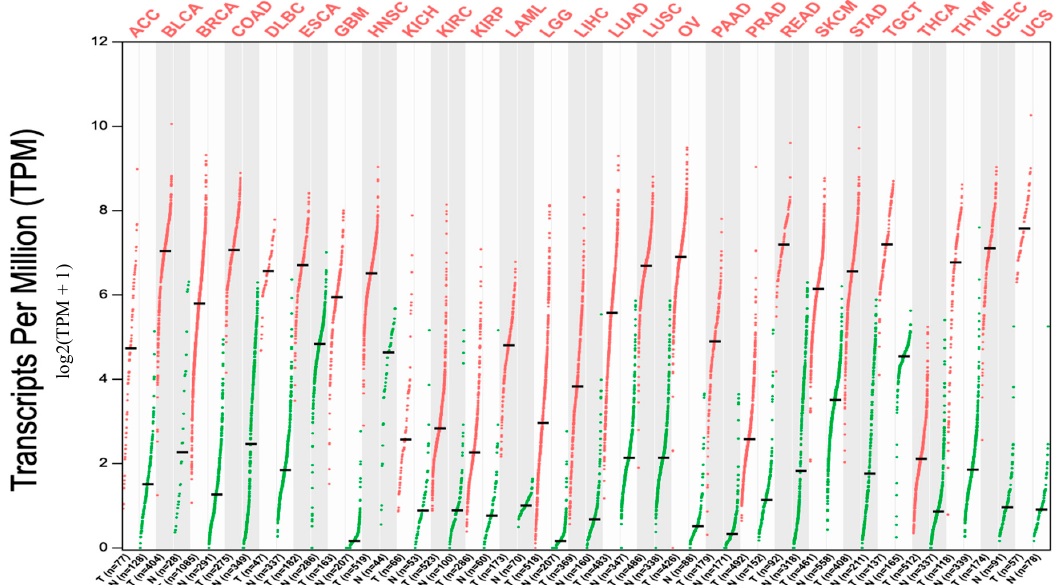
Figure 1. UBE2C expression in cancers. Expression level of UBE2C across 27 TCGA tumors compared to TCGA normal and GTEx data using GEPIA (Gene Expression Profiling Interactive Analysis) webserver. It is clear that in all 27 cancers there is notable upregulation of this gene. For each TCGA tumor (red), its matched normal and GTEx data (green) are given; T: tumor; N: normal; n: number.